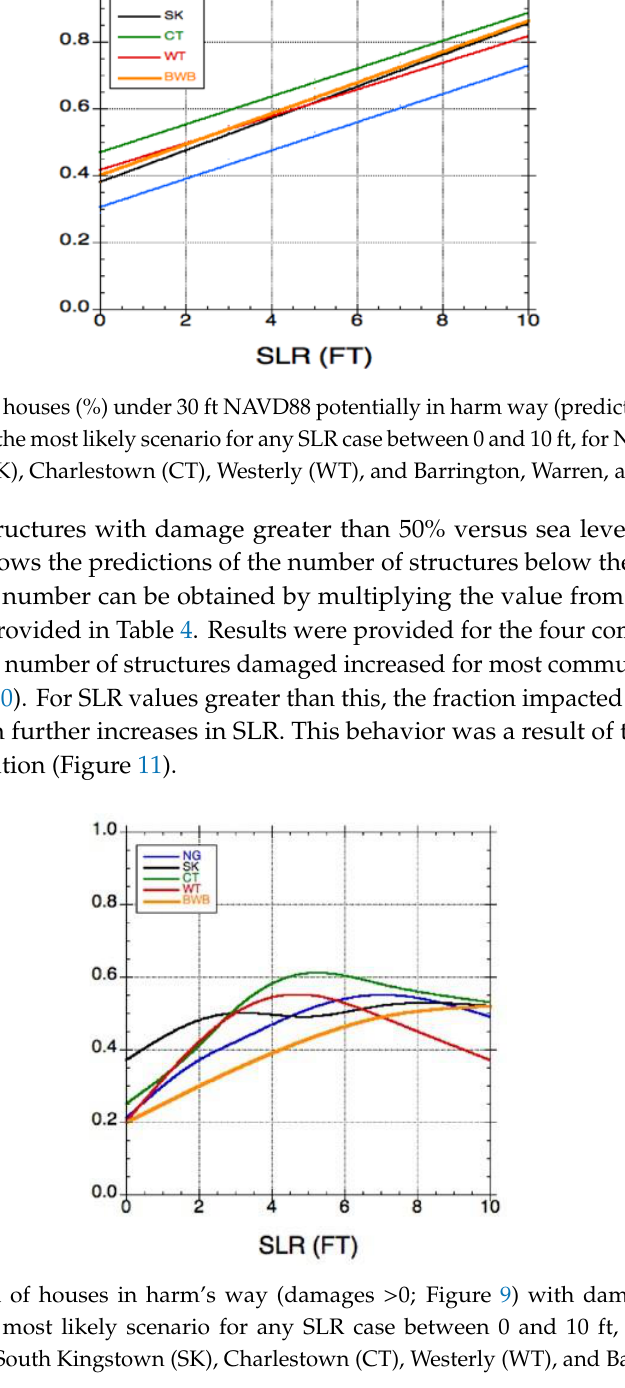
Figure 10. Fraction of houses in harm’s way (damages > 0; Figure 9) with damage greater than 50%, assuming the most likely scenario for any SLR case between 0 and 10 ft, for the towns of Narragansett (NG), South Kingstown (SK), Charlestown (CT), Westerly (WT), and Barrington, Warren, and Bristol (BWB).